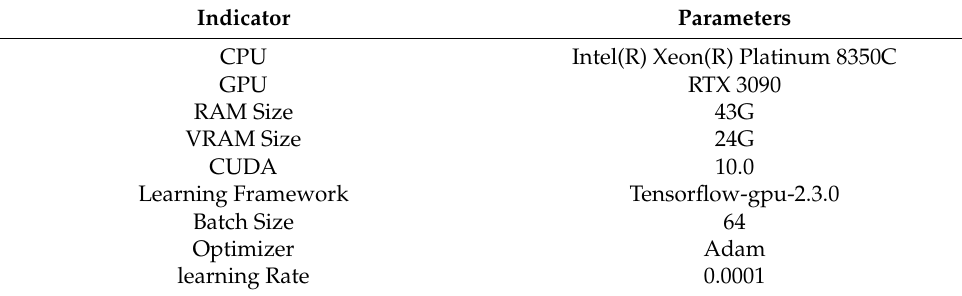
Table 1. Model training environment and